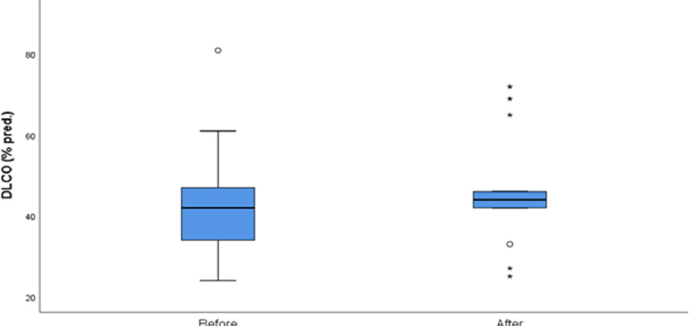
Figure 2. DLCO (% pred) before and after nintedanib treatment. Outliers are marked with a circle and extreme outliers are marked with a star.